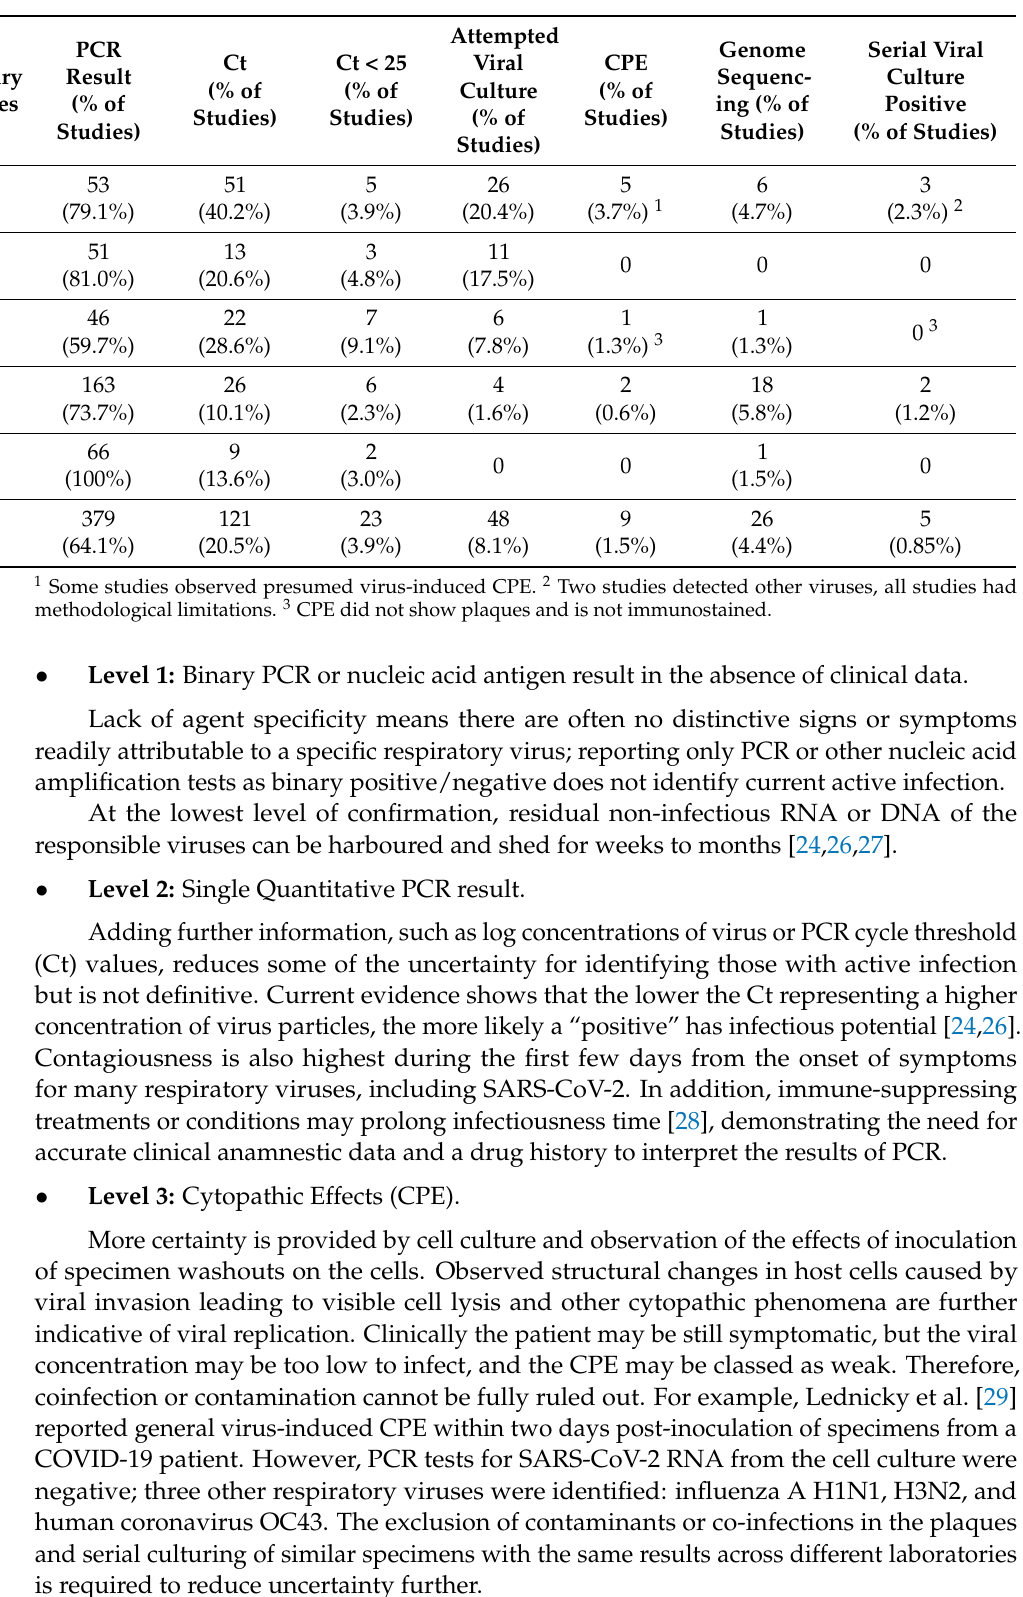
Table 6. Virological and genomic evidence reported in 591 studies included in five systematic reviews of transmission of SARS-CoV-2. Key: Ct = cycle threshold; CPE = cytopathic